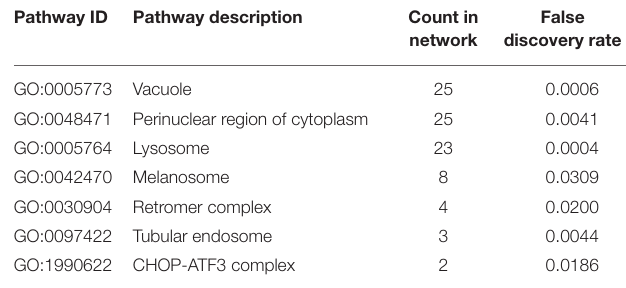
TABLE 3 | Enrichment-analysis for upregulated mRNAs in α -Gal A ( − / 0) vs. wildtype mice using gene ontology and KEGG pathway